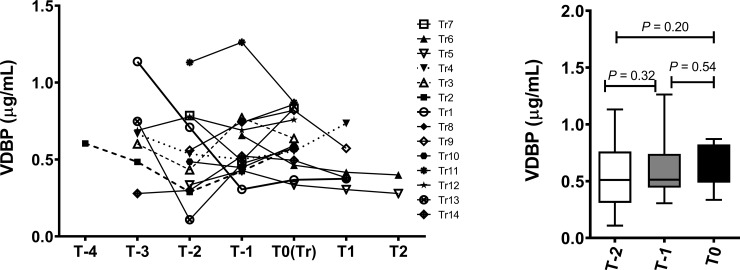
Longitudinal and cross-sectional analysis of VDBP.(A) Line graph showing the evolution of VDBP levels over-time in progressors (N = 14) prior to RA onset (T-1 to T-4), at the time of clinical diagnosis of RA onset (T0) and post-onset (T1 and T2) (B) Box-Whiskers plot showing the distribution of VDBP at two time points prior to RA onset (T-1 and T-2) and at transition point (T0). Data was analyzed by analyzed by repeated measures ANOVA using Greenhouse-Geisser model.